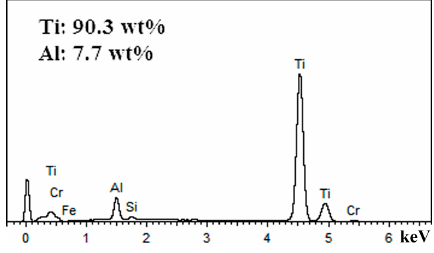
Figure 9. Analysis of chemical composition for point selected at point A in Figure 8.